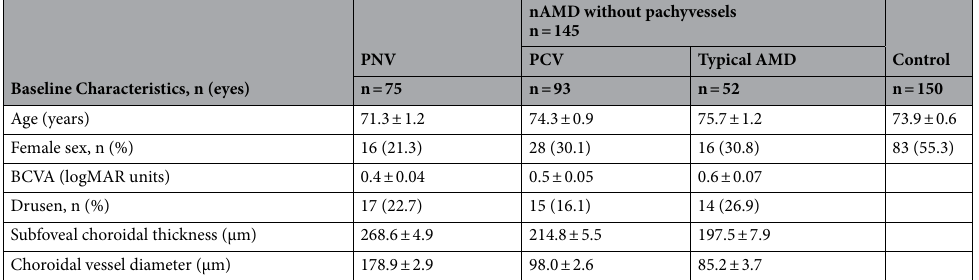
Baseline Characteristics, n